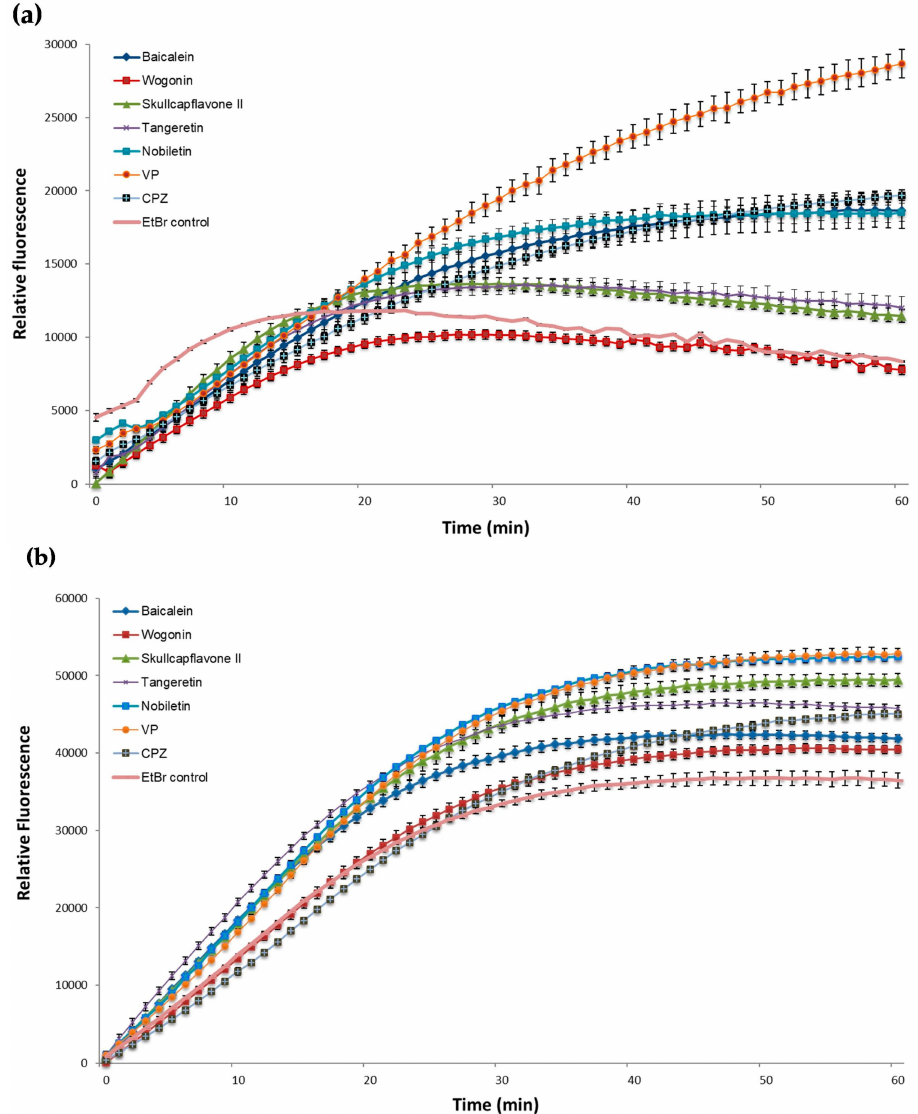
Figure 2. E ff ect of the potential EPIs and reference inhibitors on the EtBr accumulation in M. smegmatis mc 2 155 ( a ) and M. aurum ATCC 23366 ( b ). All compounds were tested at sub inhibitory concentrations at half of their MIC (Table 1). EtBr, ethidium bromide was used as negative control (drug-free culture) at a final concentration of 0.5 mg / L. VP, verapamil, a well-known e ffl ux pump inhibitor and CPZ, chlorpromazine, were integrated as positive controls. The experiments were performed in triplicate ( n = 3); values represent means +